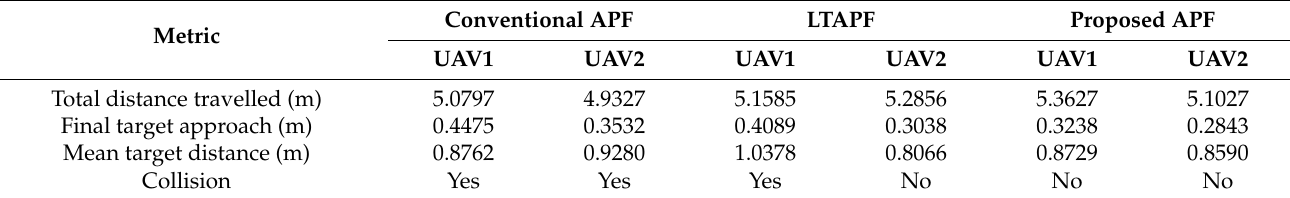
Table 5. Comparison metrics.